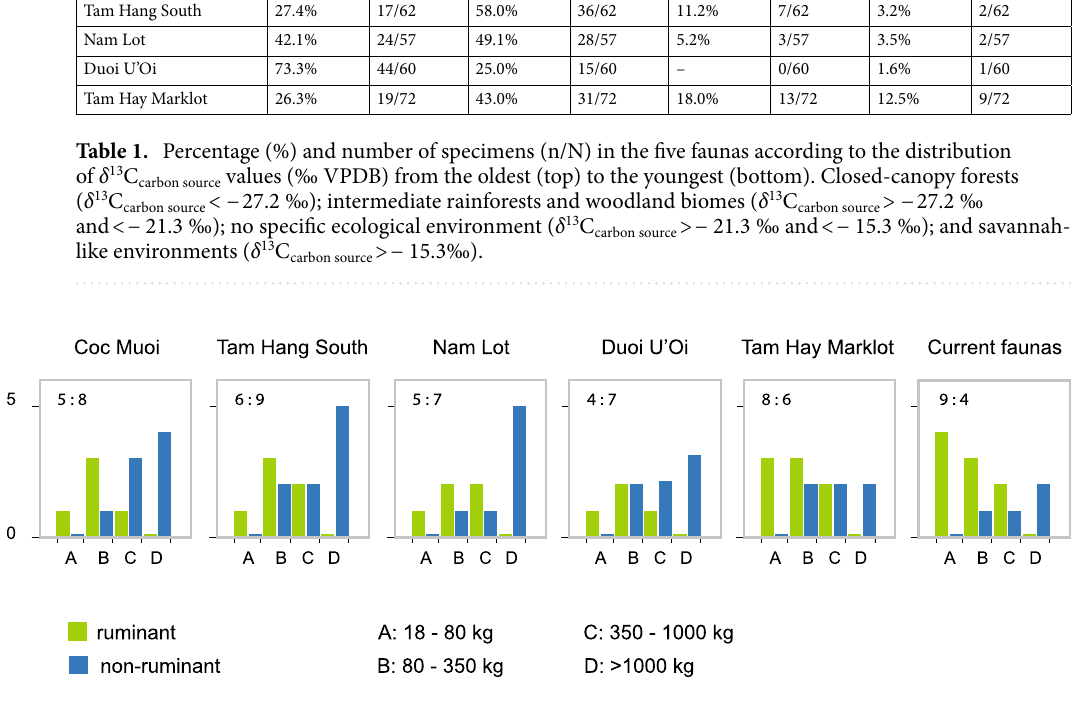
Figure 4. Number of species by body mass category and digestive strategy in the five faunas, following a chronological sequence from the oldest (left) to the youngest (right). The ratio refers to the number of ruminants versus non-ruminant taxa. See Supplementary Table S10 for the list of taxa within each body mass